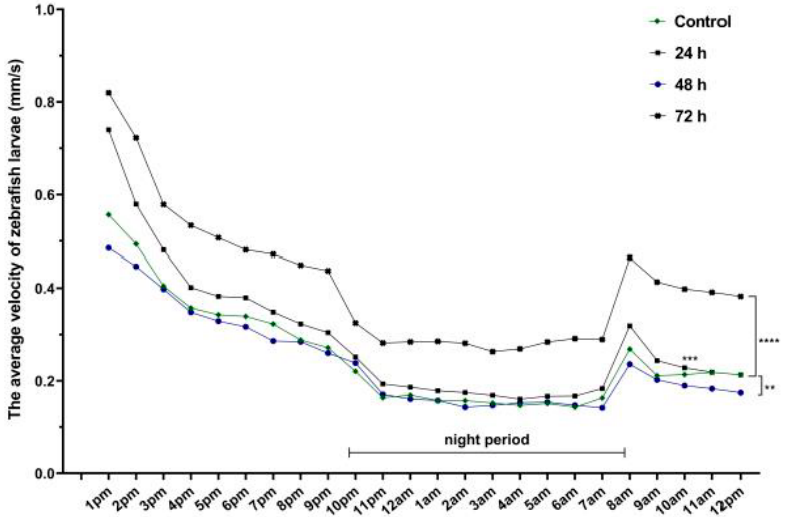
Figure 4. The average velocity of 6-day-old zebrafish larvae recorded during 24 h ( n = 30). Group 1, control; Group 2, group exposed for 24 h to VPA; Group 3, group exposed for 48 h to VPA; and Group 4, group exposed for 72 h to VPA. The data is represented as average ± SEM. Anova and Tukey post-hoc tests, p < 0.05 was considered to be significant. The experimental groups were compared to control group, where ** p < 0.01; *** p < 0.001 and **** p < 0.0001.